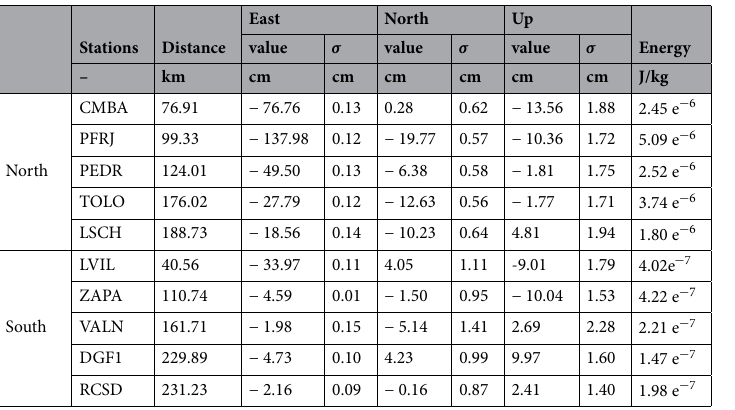
◦ ) from all the 118 GPS stations.